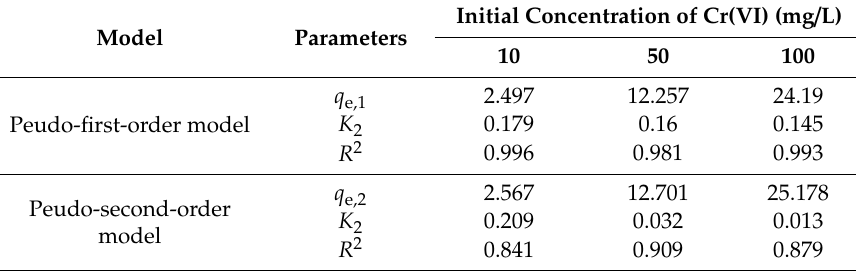
Table 1. Adsorption kinetics parameters for Cr(VI) adsorption onto CKB.